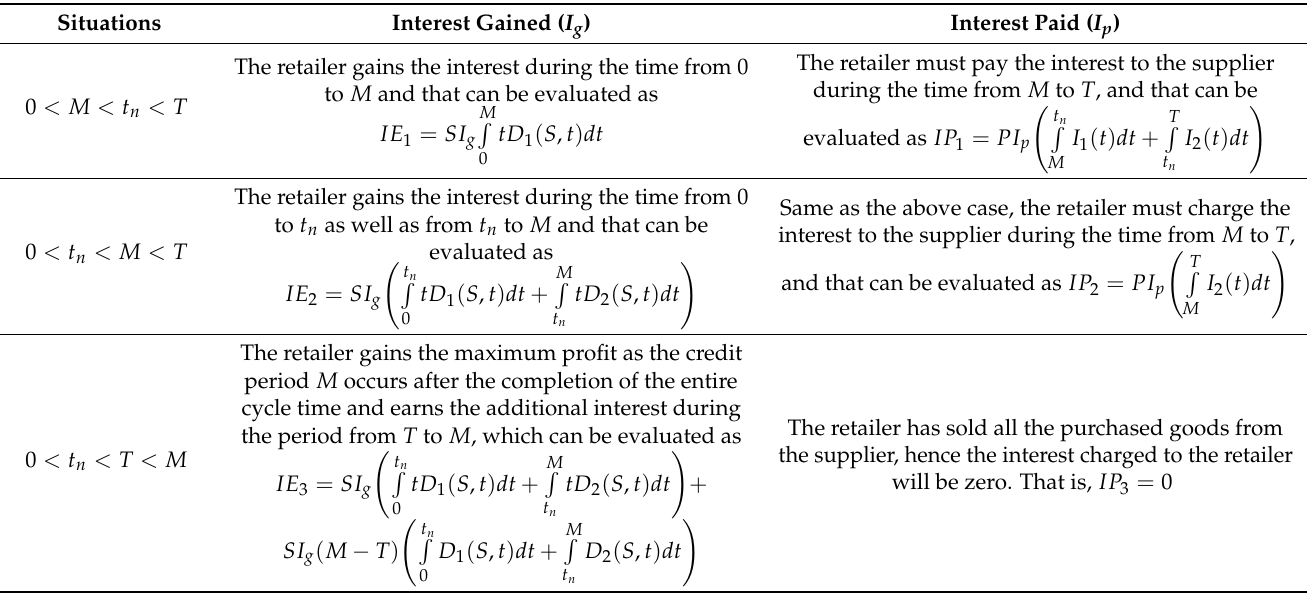
Table 2. Interest gained and interest paid by the retailer for each